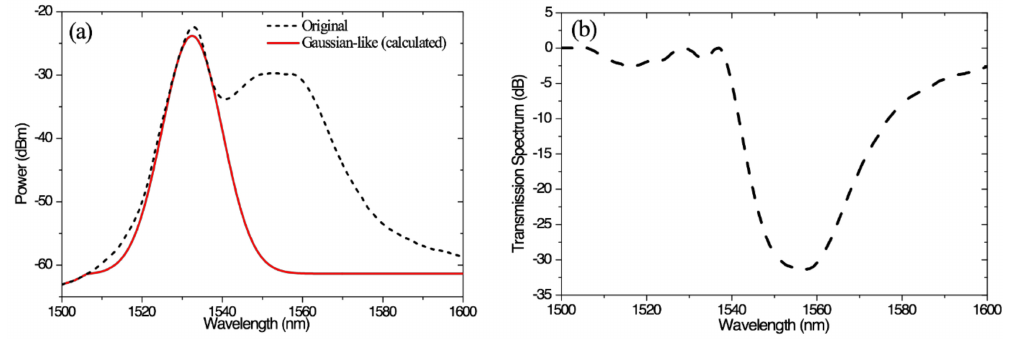
Figure 5. ( a ) Original spectrum and expected trimming spectrum and ( b ) transmission spectrum of the expected filter.